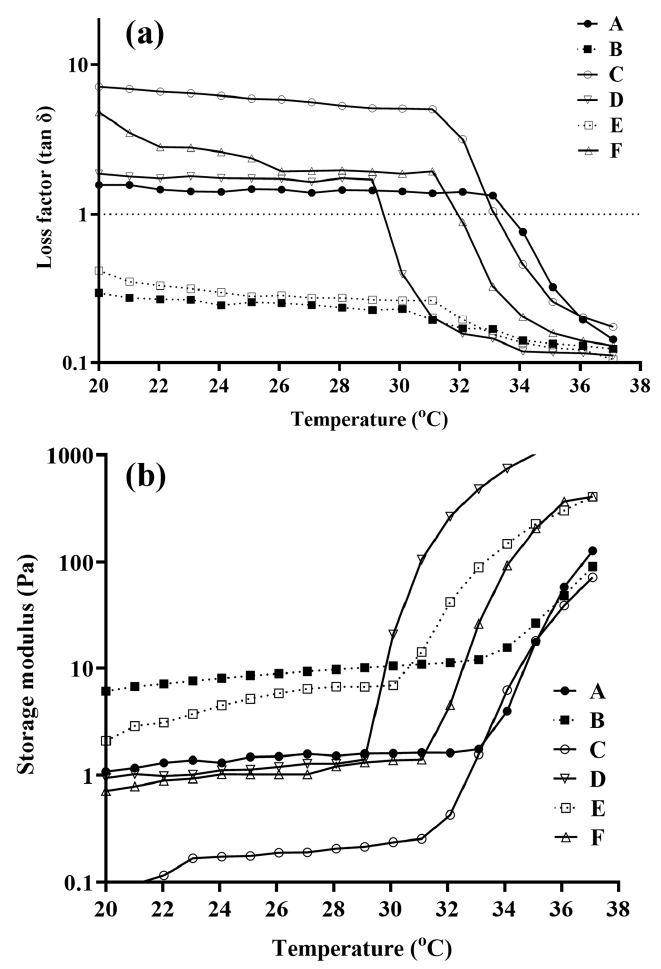
Figure 4. Semi ‐ logarithmic plots of ( a ) loss tangent (tan δ ) and ( b ) storage modulus (G’) of an opti ‐ mized blank dual ‐ responsive in situ gel and an NEB ‐ loaded dual ‐ responsive in situ gel as a function of temperature in presence of STF and deionized (DI) water. Rheological studies of optimized blank and NEB ‐ loaded in situ gels. Note: A—blank dual ‐ responsive in situ gel; B—blank dual ‐ responsive in situ gel in the presence of STF; C—blank dual ‐ responsive in situ gel in the presence of DI water; D—NEB ‐ loaded dual ‐ responsive in situ gel; E—NEB ‐ loaded dual ‐ responsive in situ gel in the pres ‐ ence of STF and F—NEB ‐ loaded dual ‐ responsive in situ gel in the presence of DI water.